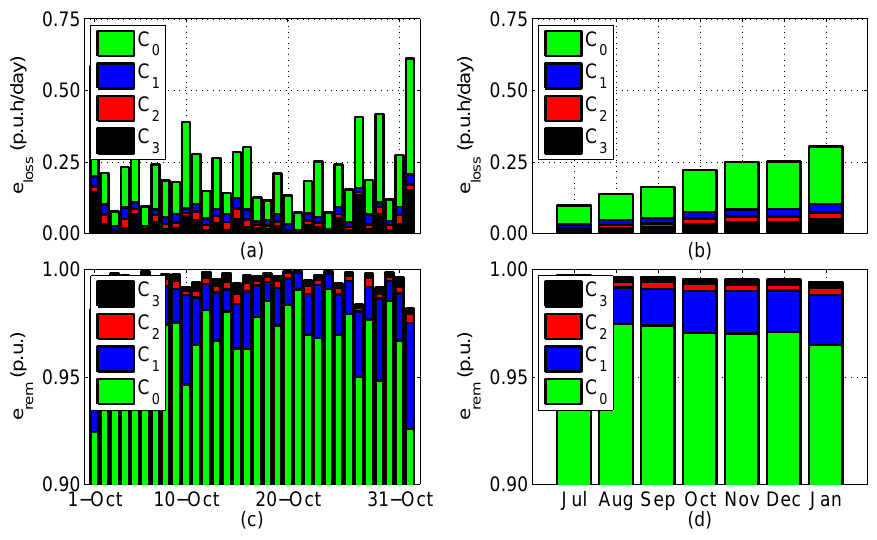
Figure 18. USPVP energy losses due to FR during a year in Chile, with f 1 at 52 Hz, for several ESS scenarios: C at 0.00277 p.u.h ( C 1 ), 0.00833 p.u.h ( C 2 ), 0.015 p.u.h ( C 3 ) and without BESS ( C 0 ): ( a ) Daily energy losses ( e loss ) in October; ( b ) monthly energy losses; ( c ) daily remnant energy ( e rem ) in October; and ( d ) monthly remnant energy.